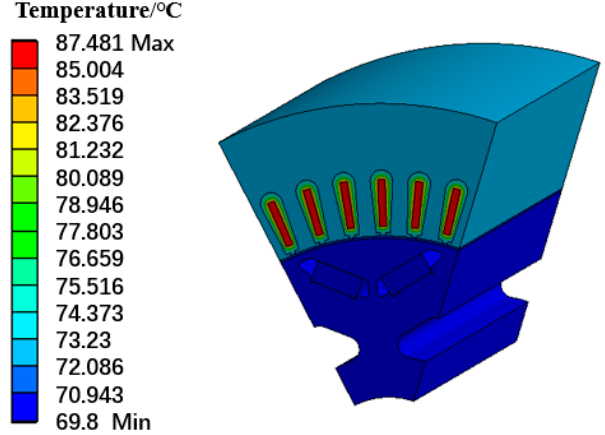
Figure 7. Motor temperature distribution diagram.